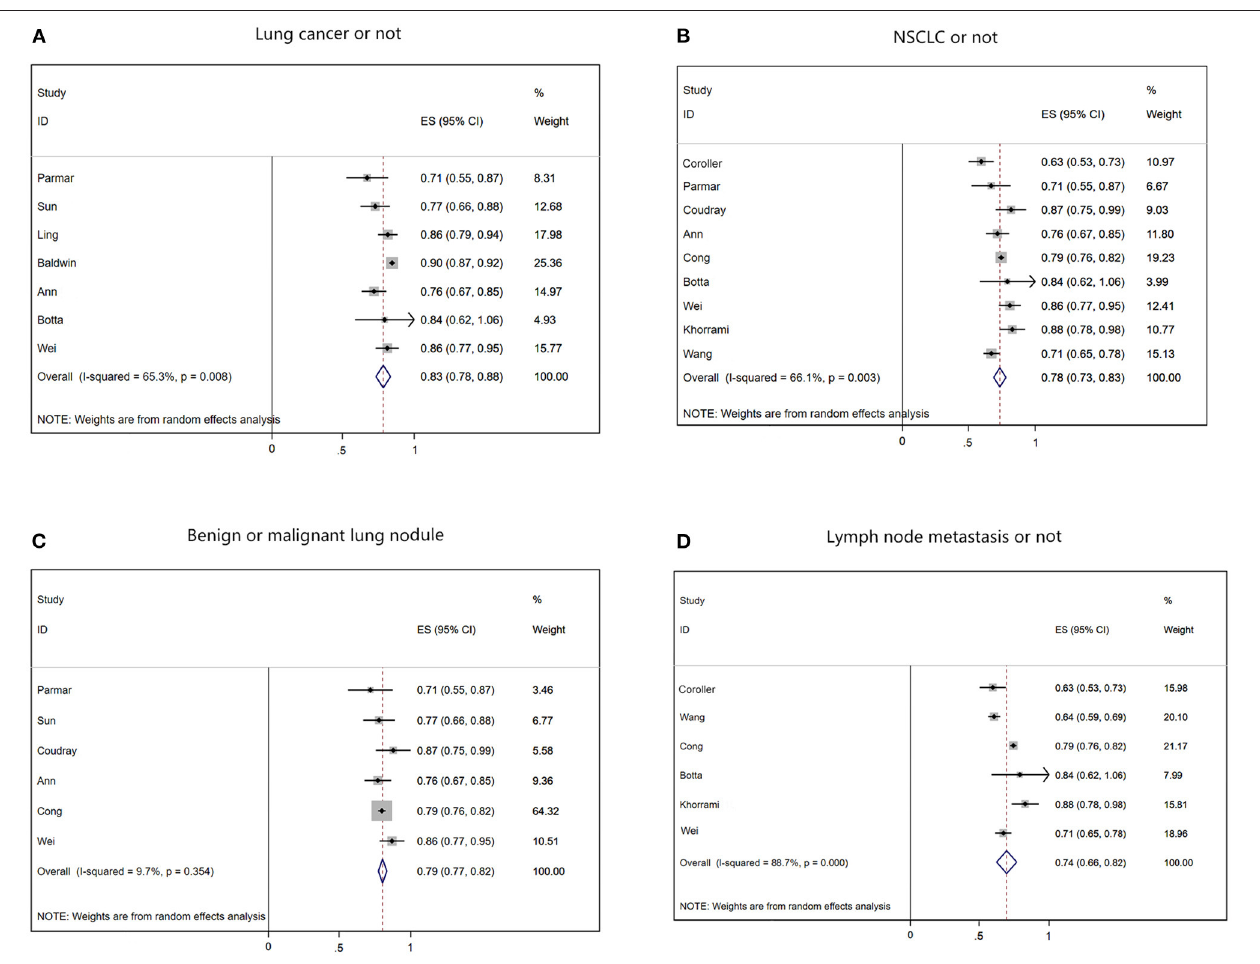
FIGURE 2 | Summary of forest plots for different classifications. (A) The forest plot of determine if a patient has lung cancer. (B) The forest plot of determining whether the cancer type is NSCLC. (C) The forest plot of predicting benign and malignant pulmonary nodules. (D) The forest plot of predicting lymph node metastasis in lung